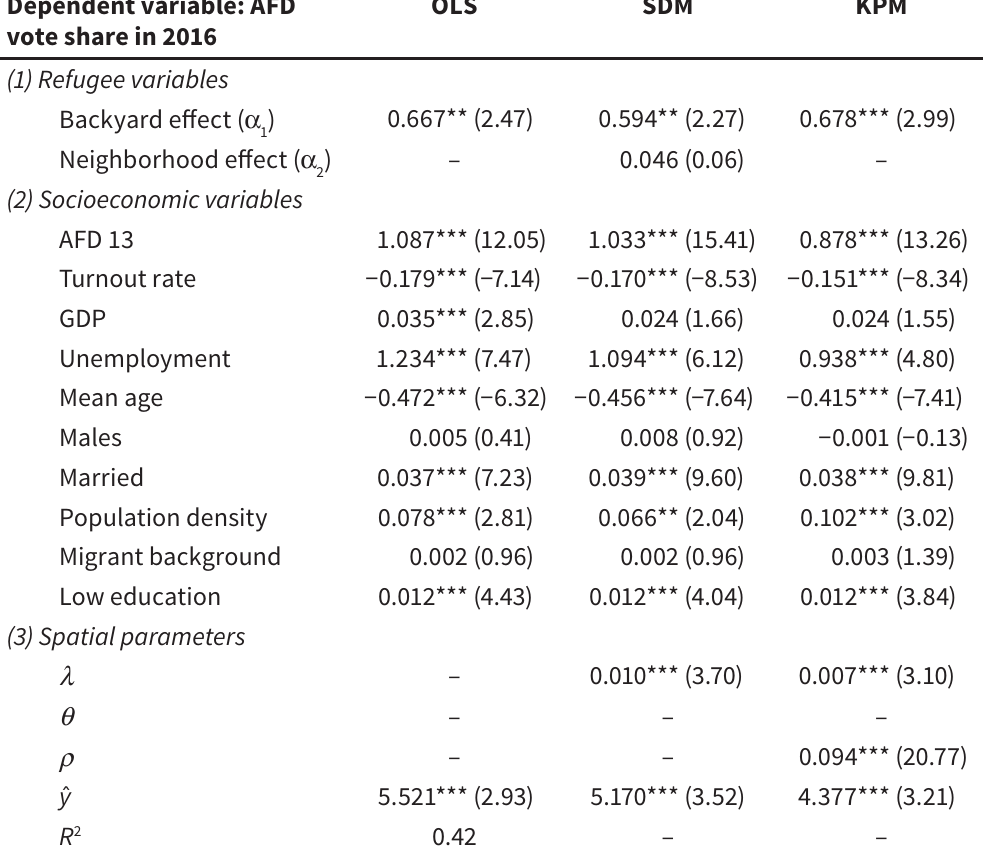
Vote share estimates for the AFD in the year 2016 (in percentage points) Dependent variable: